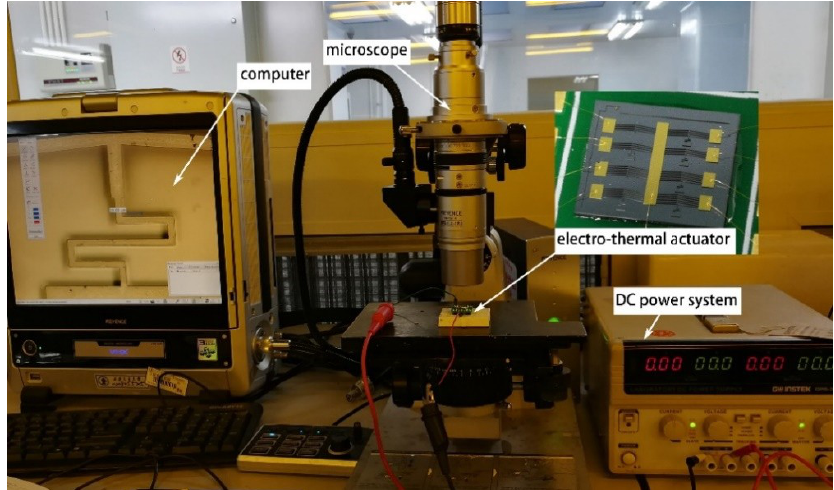
Figure 11. The measurement stage of the actuation force.